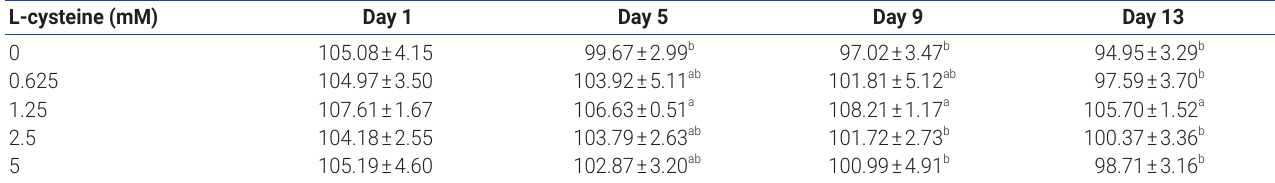
Table 4. Effects of different concentrations of cysteine on sperm curvilinear velocity (VCL, μm/s) during the liquid storage L-cysteine (mM)